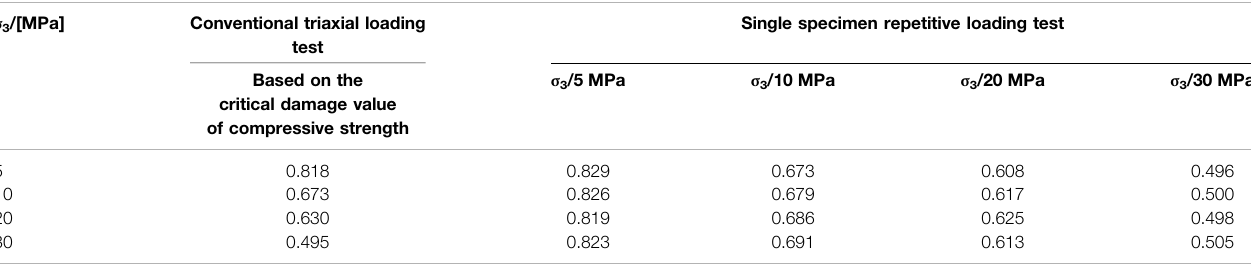
TABLE 2 | Comparison ofthe results ofconventional triaxialloadingand repeatedloadingofsingle specimensbasedon thecriticaldamage values ofcompressive strength. σ 3